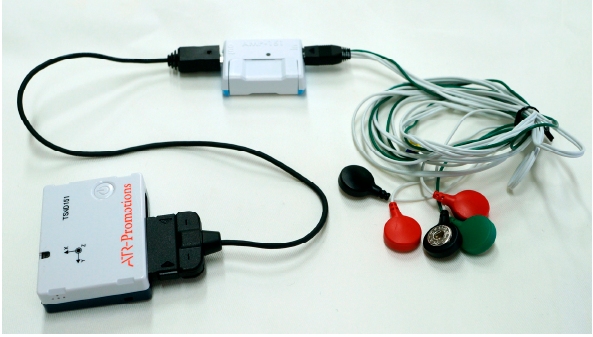
Figure 1. Appearance of sensors for motion